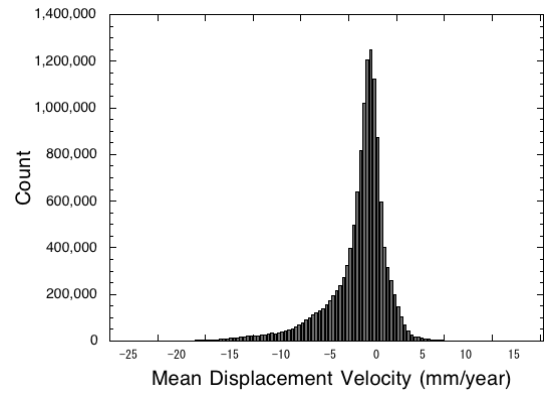
Figure 5. Mean displacement velocity from 2015 to 2019, derived from the PALSAR-2 data